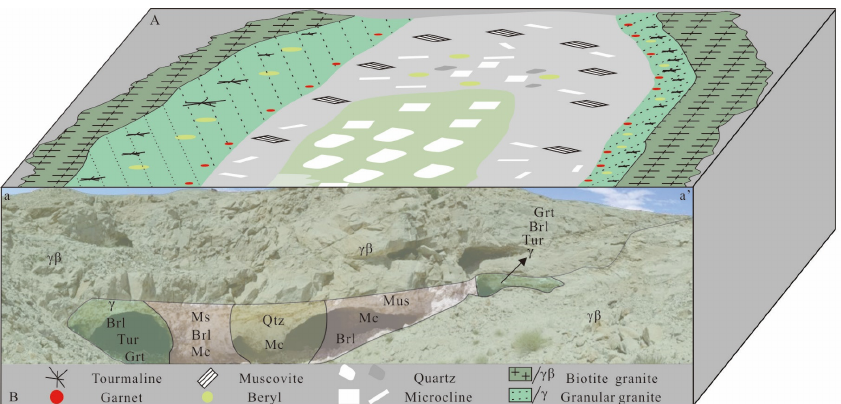
Figure 2. Geological sketch of the Dakalasu pegmatite veins in the Altay region of Xinjiang, modi- fied after [35,56]. ( A ) Geological overview of Dakalasu pegmatite ore cluster; ( B ) Simplified Geo- logical Map of Dakalasu Be-Nb-Ta Ore District.